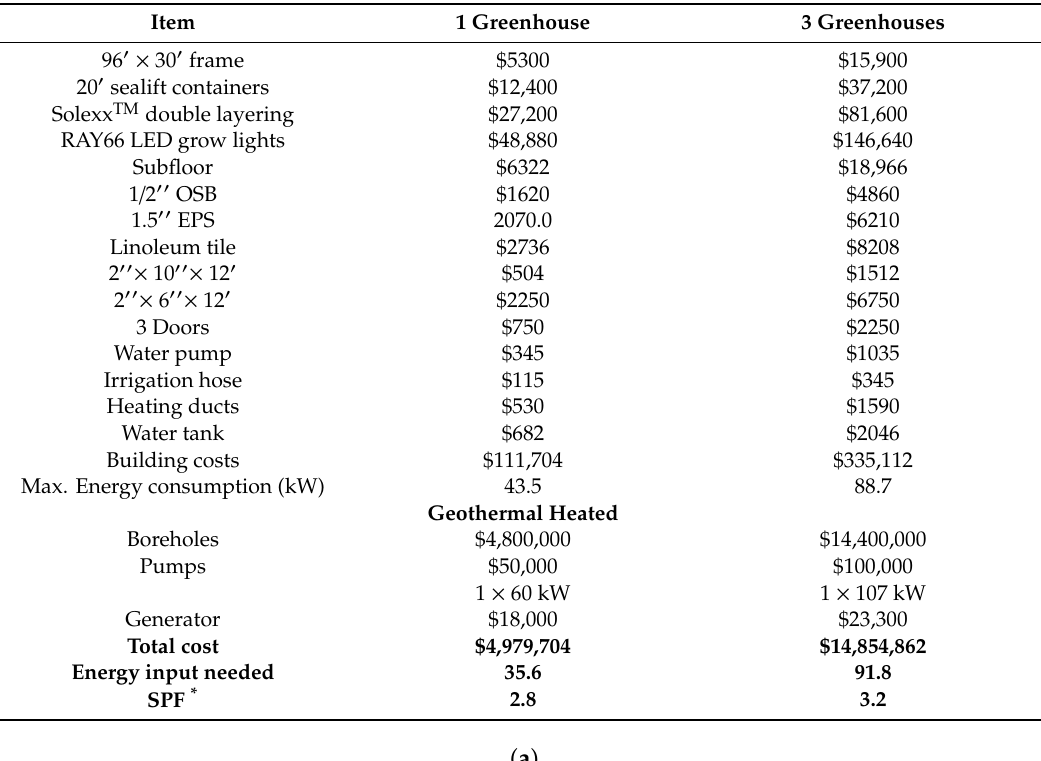
Table 12. Cost for 96 (cid:48) × 30 (cid:48) greenhouses in ( a ) Resolute and ( b ) ON in